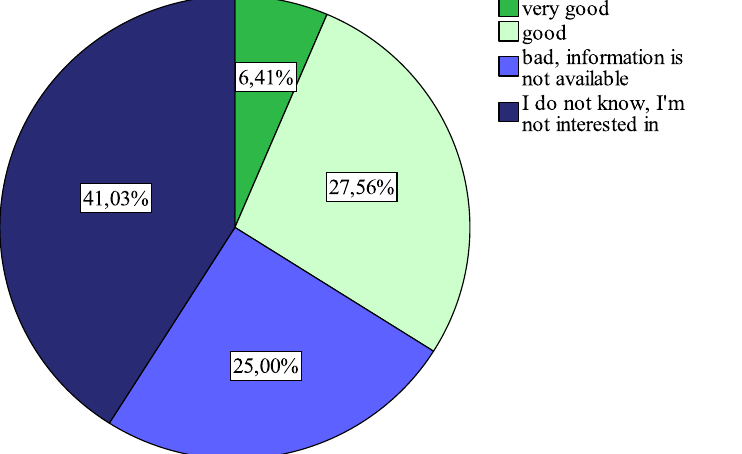
Fig. 4. The perceived availability of information about natural environmental protection in Bielsko-Biała